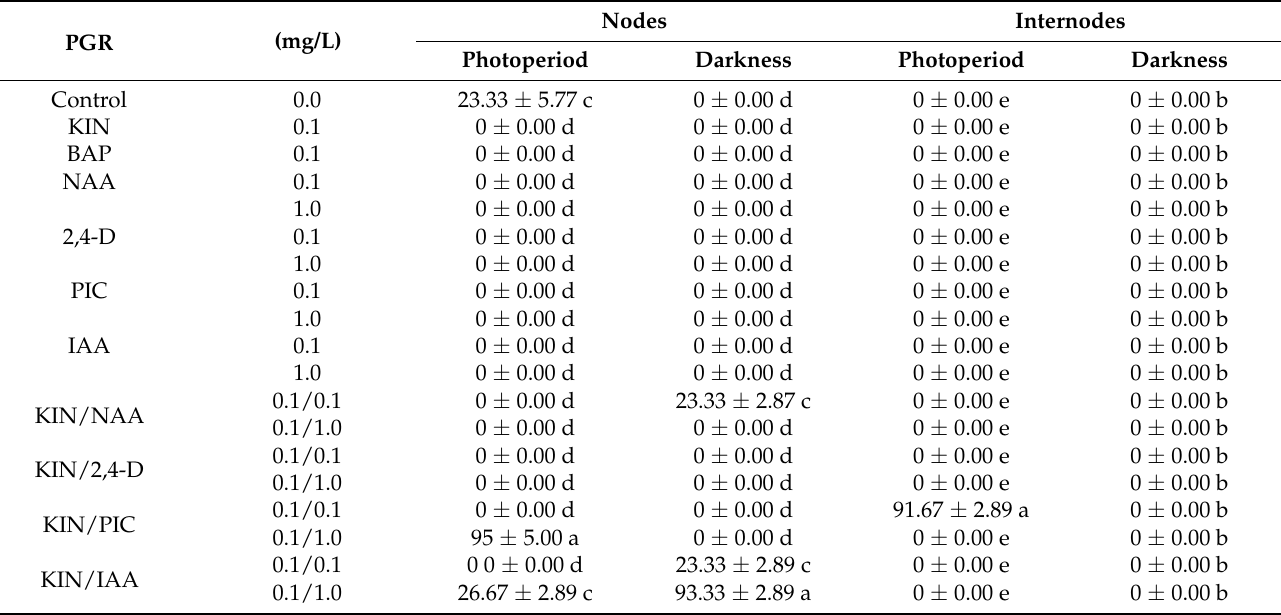
Table 3. Effect of plant growth regulators on seedlings regeneration of A. ludoviciana through internodal and nodal segments in two incubation